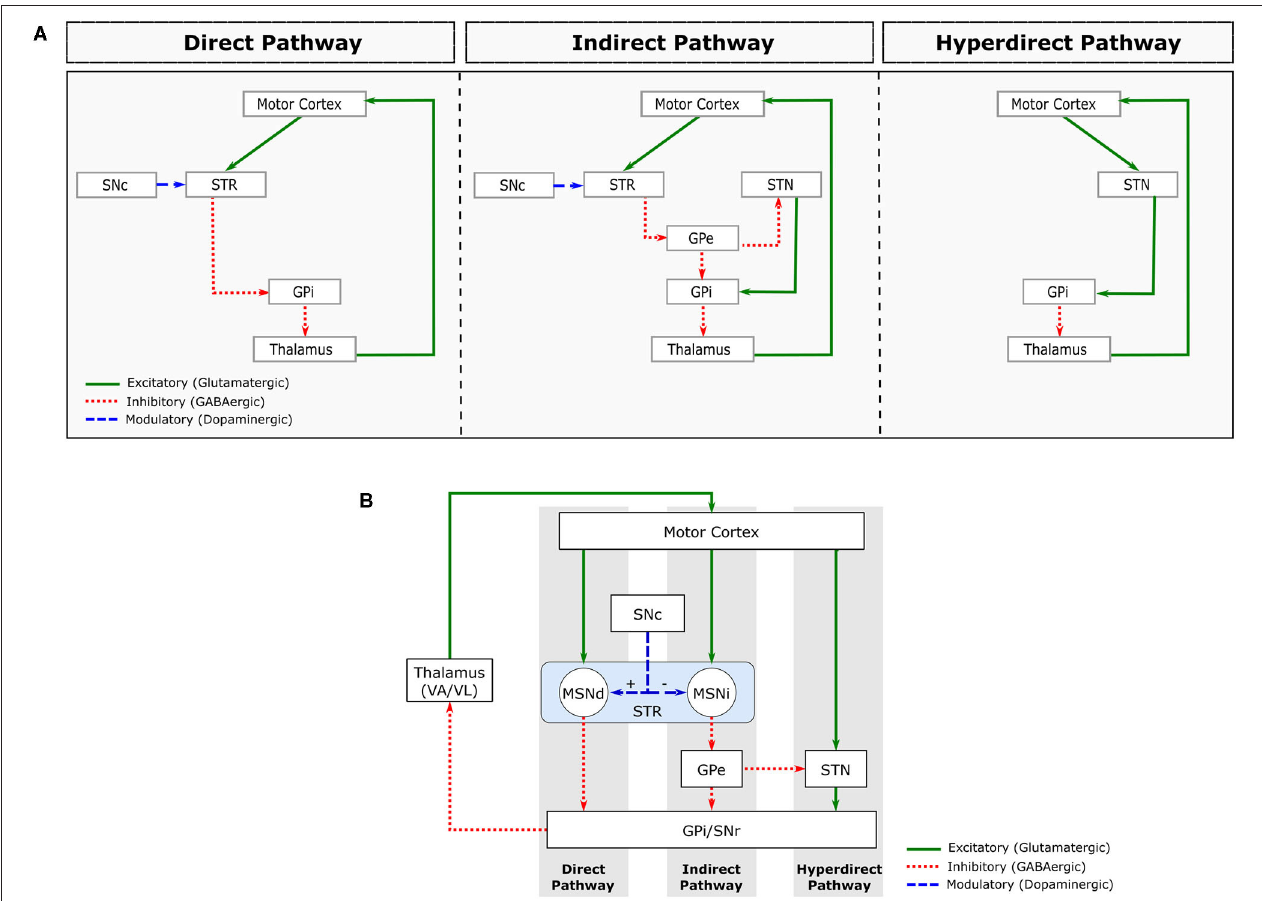
FIGURE 2 | Major pathways comprising the sensorimotor loop. (A) Schematic representation of the direct (left), indirect (centre) and hyperdirect (right) pathways. (B) Combined representation of these pathways. STR, striatum; MSNd, medial spiny neurons of the direct pathway; MSNi, medial spiny neurons of the indirect pathway; SNc, substantia nigra pars compacta; GPe, globus pallidus pars externa; GPi, globus pallidus pars interna; STN, subthalamic nucleus; VA/VL, ventroanterior and ventrolateral thalamic